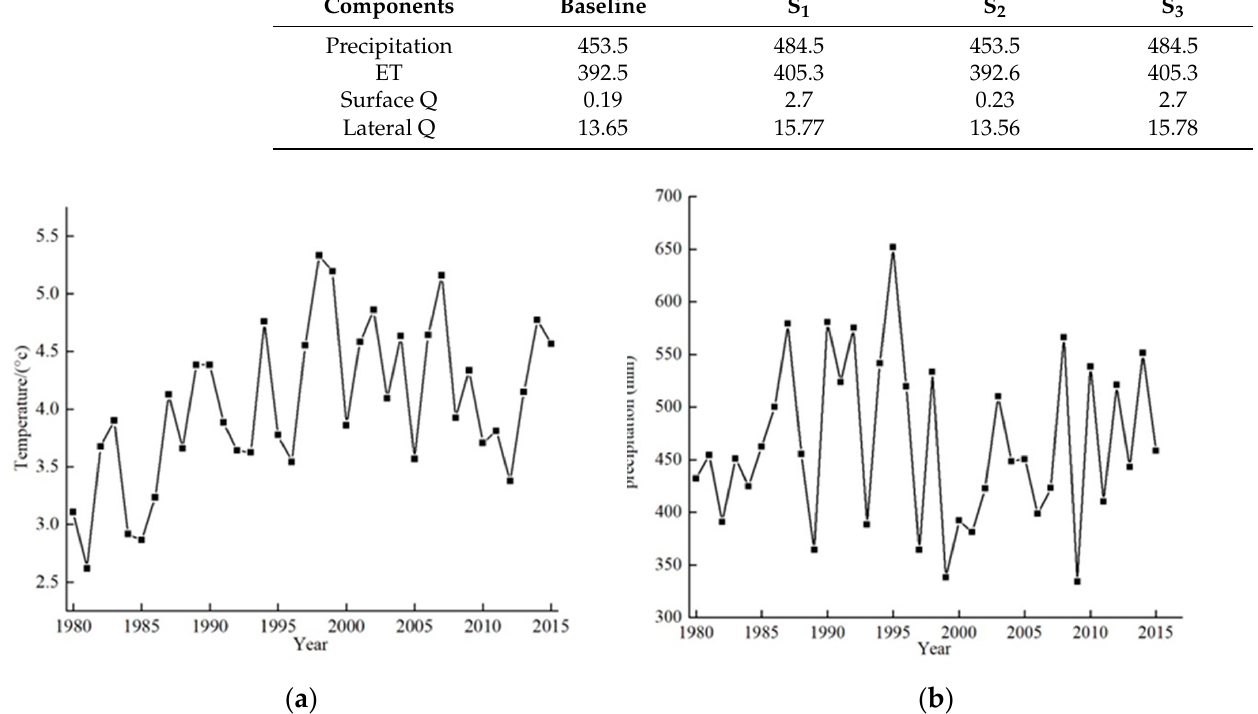
Figure 5. Trends of precipitation ( a ) and temperature ( b ) from 1980 to 2016.